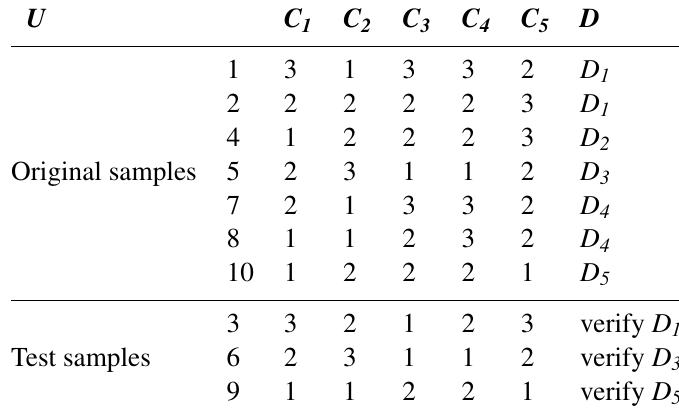
Table 3 Decision table after